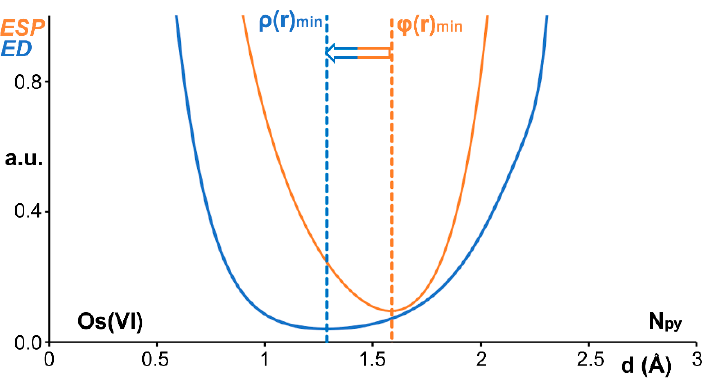
Figure 5. The ED (blue curve) and ESP (orange curve) 1D profile along the Os(VI)···N for complex 4